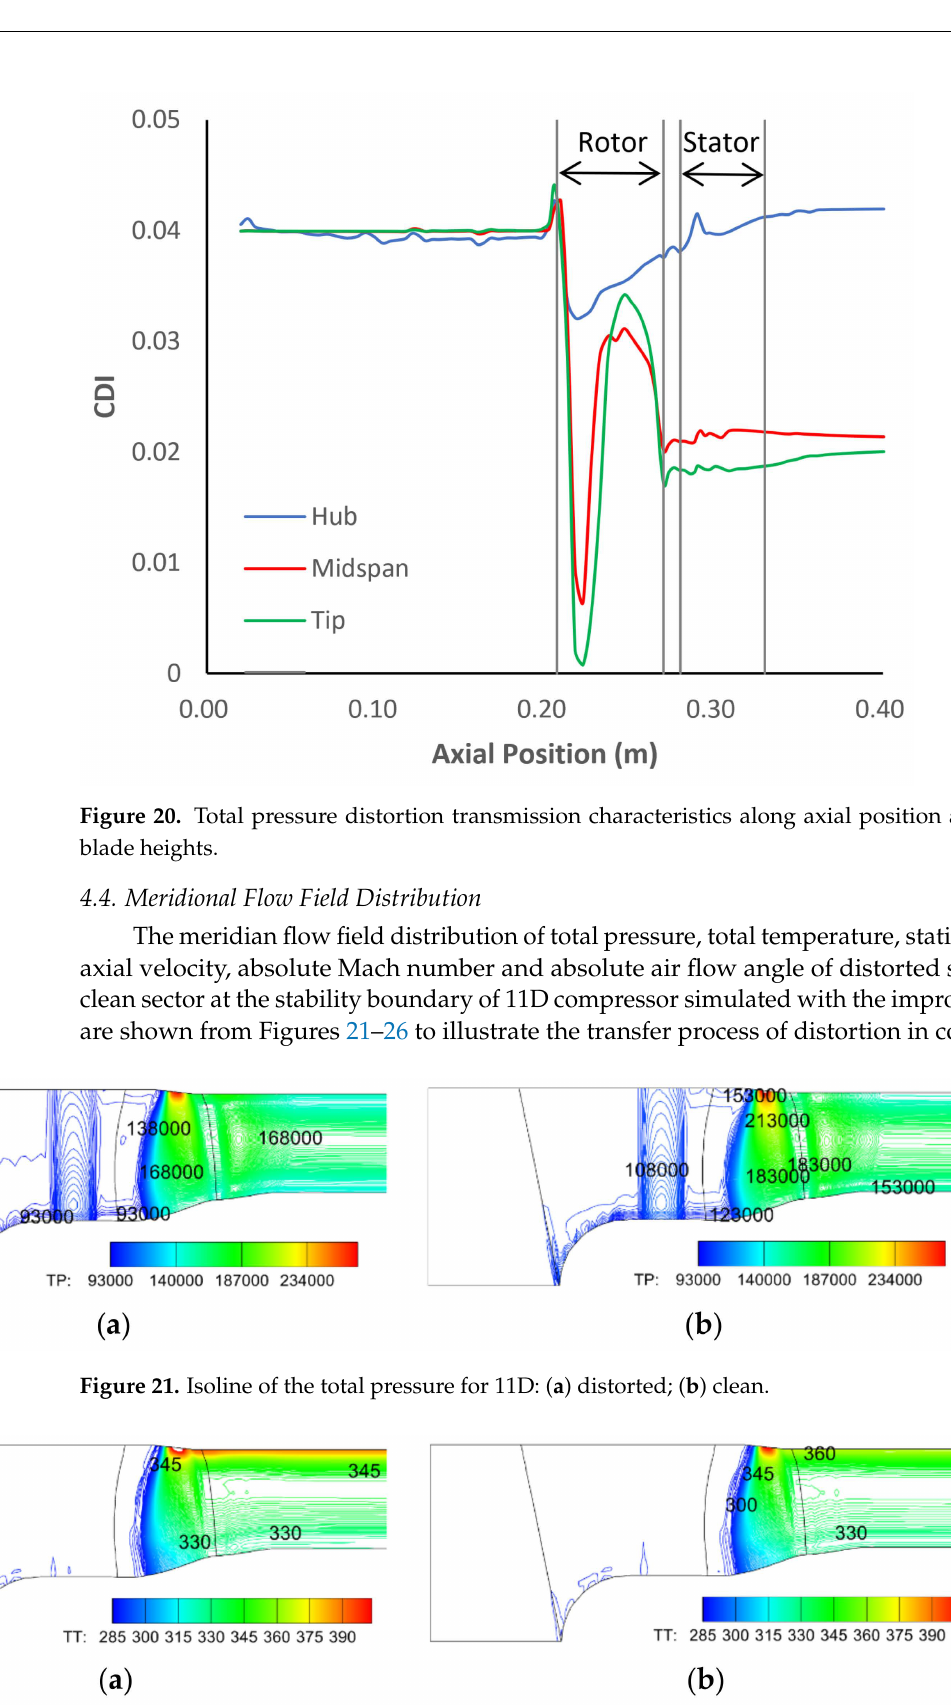
Figure 22. Isoline of the total temperature for 11D: ( a ) distorted; ( b )